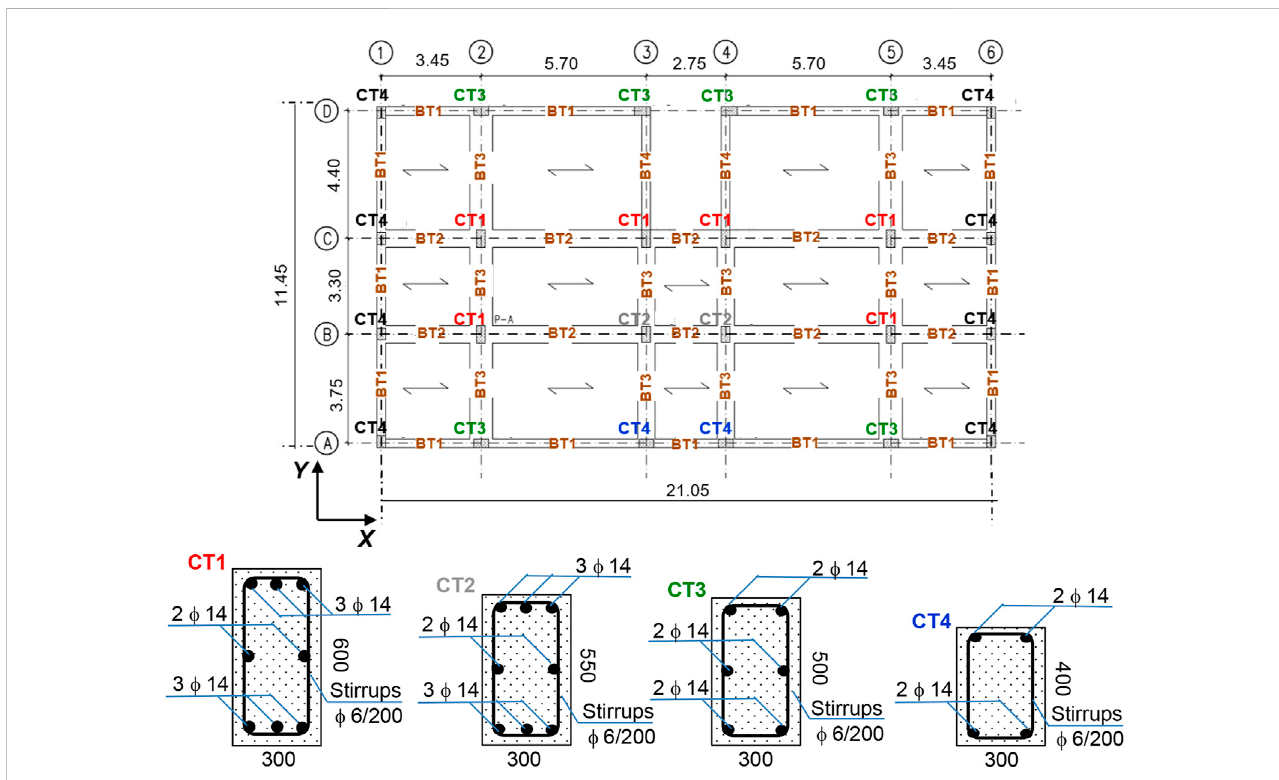
FIGURE 3 Structural plan of the building (ground storey, dimensions in meters) and cross sections of columns CT1 through CT4 (dimensions in